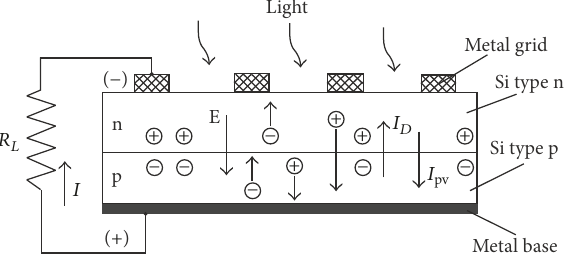
Figure 1: Physical structure of the photovoltaic cell.